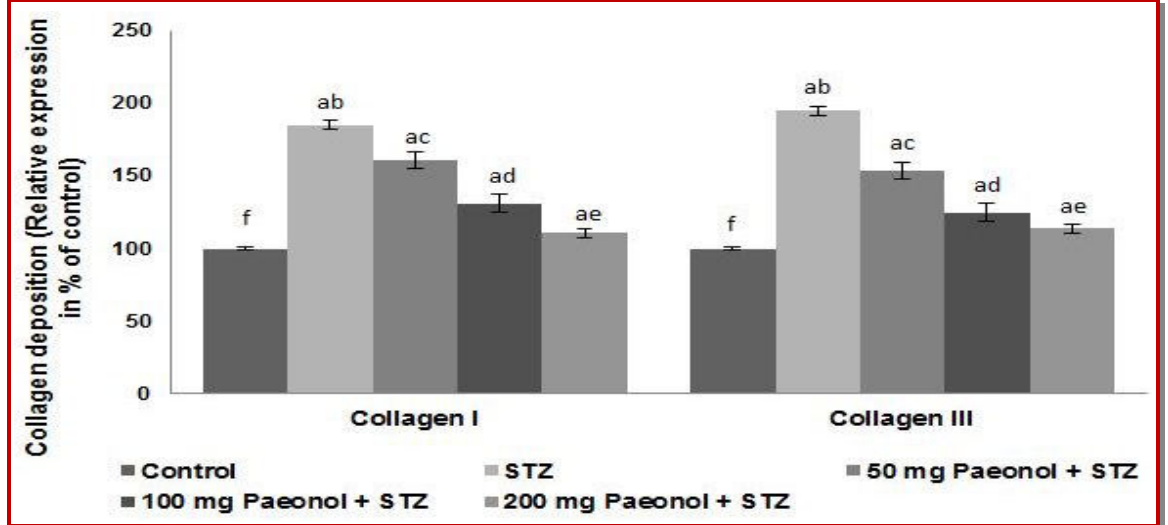
Figure 3: Effect of paeonol on collagen deposition in cardiac tissues Values are represented as mean ± SD; n=6; a represents statistical significance at p<0.05 compared against respective controls and b-f represents significant difference (p<0.05) between mean values within the groups as determined by one-way ANOVA followed by DMRT